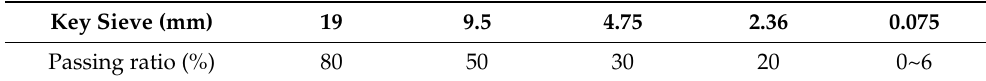
Table 7. Uniform grading requirements for LMR-CSPB.